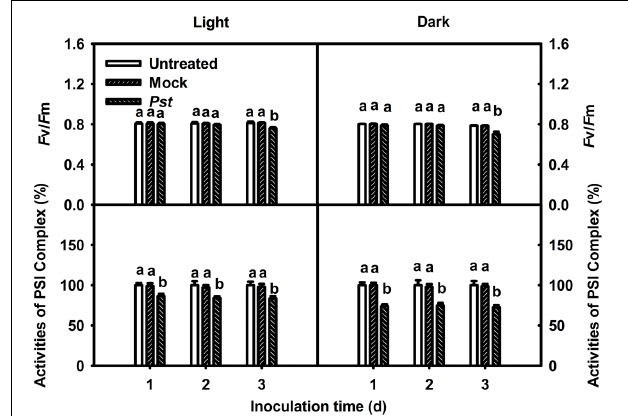
FIGURE 2 | Relative changes in F v / F m and PSI complex activity after Pst infection of tobacco leaves. Chlorophyll a fluorescence transients were analyzed with the JIP-test. The maximum quantum yield of PSII ( F v / F m ) and PSI complex activity values were calculated after tobacco leaves were inoculated with distilled water (Mock) or Pst for different durations under light (200 µ mol m − 2 s − 1 ) or dark conditions. The initial PSI complex activity of untreated tobacco leaves was taken as 100%; the activities of mock- and Pst -treated leaves were calculated as the percentage of activity in untreated leaves. Means ± SE of 10 replicates are presented. Different letters above the columns indicate significant differences between treatments at P < 0.05.